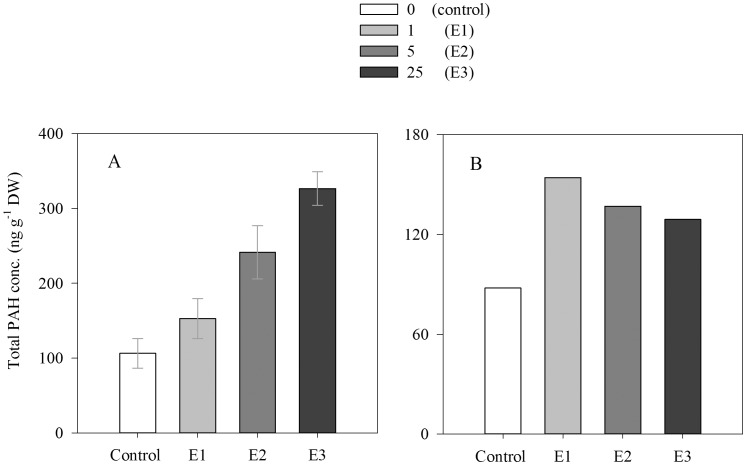
Total concentration of the polycyclic aromatic hydrocarbons (total PAHs) detected in adult stages of scyphozoan Aurelia aurita (A) and the ctenophore Mnemiopsis leidyi (B) after 6 days of exposure to different concentrations of crude oil.(Control: no oil, E1: 1 µL L−1, E2: 5 µL L−1, E3: 25 µL L−1.) Error bars represent the standard errors.